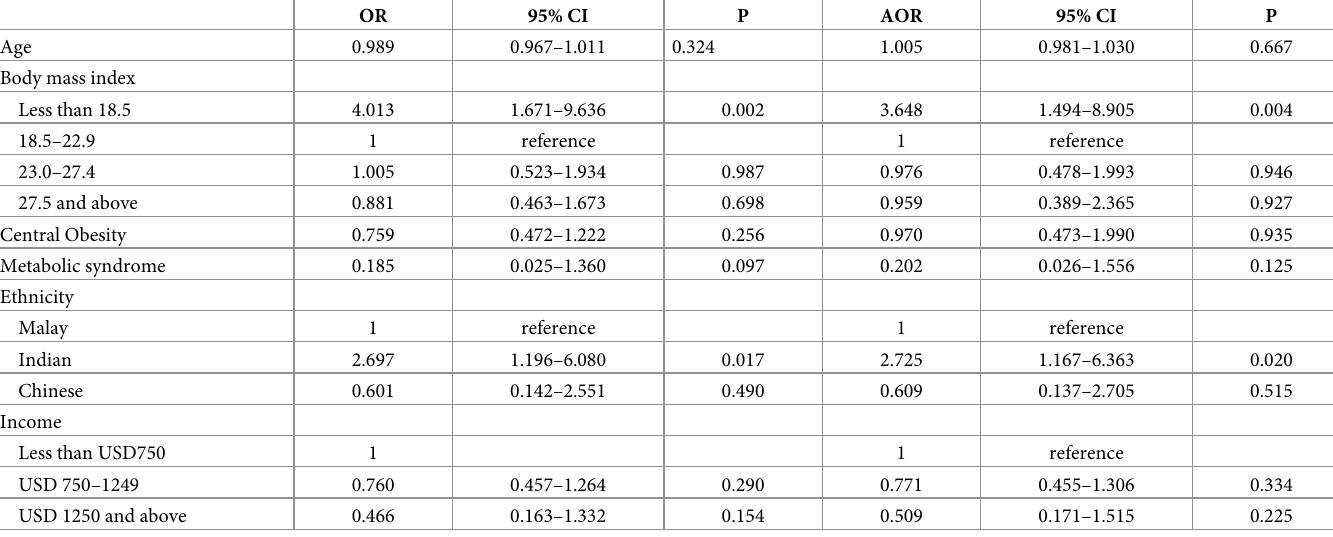
Table 2. Multivariate analysis of risk factors for functional dyspepsia (N = 870).